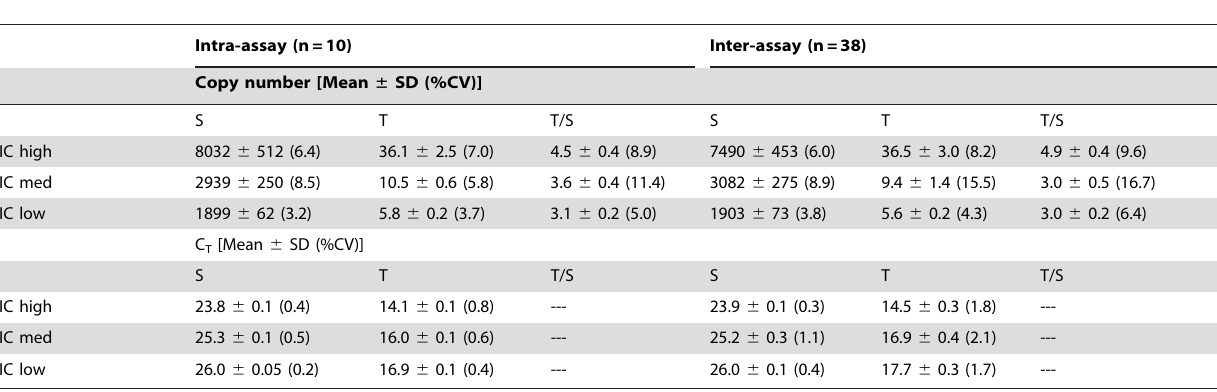
Table 1. Intra-assay and inter-assay variability for the calculated copy number and cycle threshold (C T ) for the three internal controls (IC).